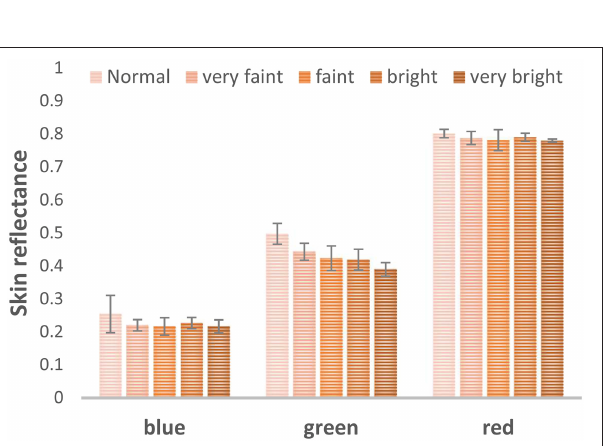
FIGURE 9 | Skin reflectance computed from the color images blue, green, red channels to examine the most sensitive part of the visible region to erythema development.